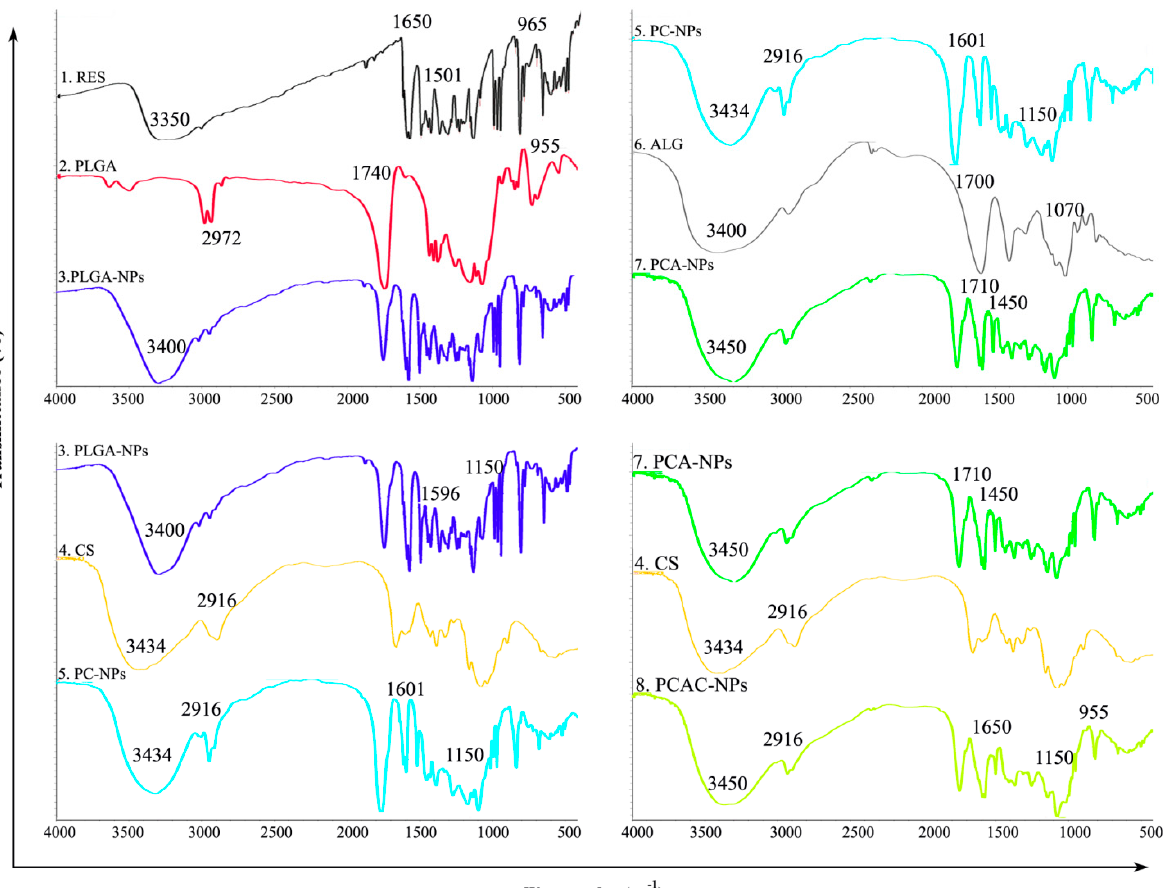
Figure 3. FT-IR of (1) RES, (2) PLGA, (3) RES-loaded PLGA-NPs, (4) CS, (5) RES-loaded PC-NPs, (6) ALG, (7) RES-loaded PCA-NPs and (8) RES-PCAC-NPs.